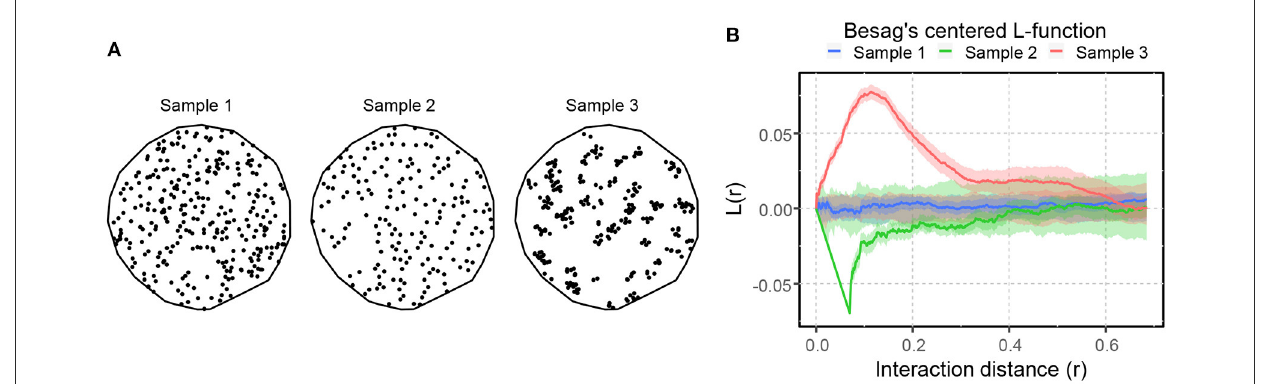
FIGURE4 An illustration of spatial point patterns with different spatial interactions. (A) SPPs portraying complete spatial randomness (sample 1), spatial inhibition (sample 2), and spatial attraction (sample 3). (B) Besag’s centered L -function computed for the patterns shown in (A) . The solid lines illustrate the spatial interaction of the patterns compared to CSR. The shaded area around the solid lines shows the boundaries of 95-percentile confidence interval.